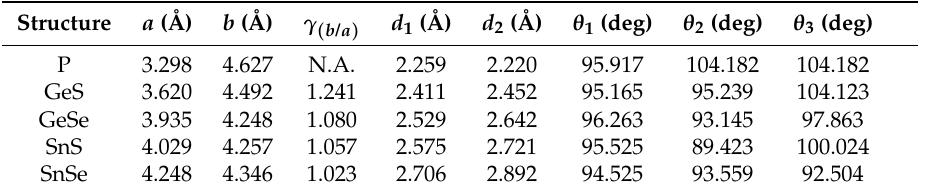
Figure 1. Atomic structure of group IV monochalcogenides MX in a 3 × 3 × 1 supercell from ( a ) top view and ( b , c ) side views. Table 1. The optimized lattice constants, bond length and bond angle for monolayer black phosphorene and phosphorene analogues (monolayer group IV monochalcogenides MX ) ( M = Ge, Sn; X = S, Se),